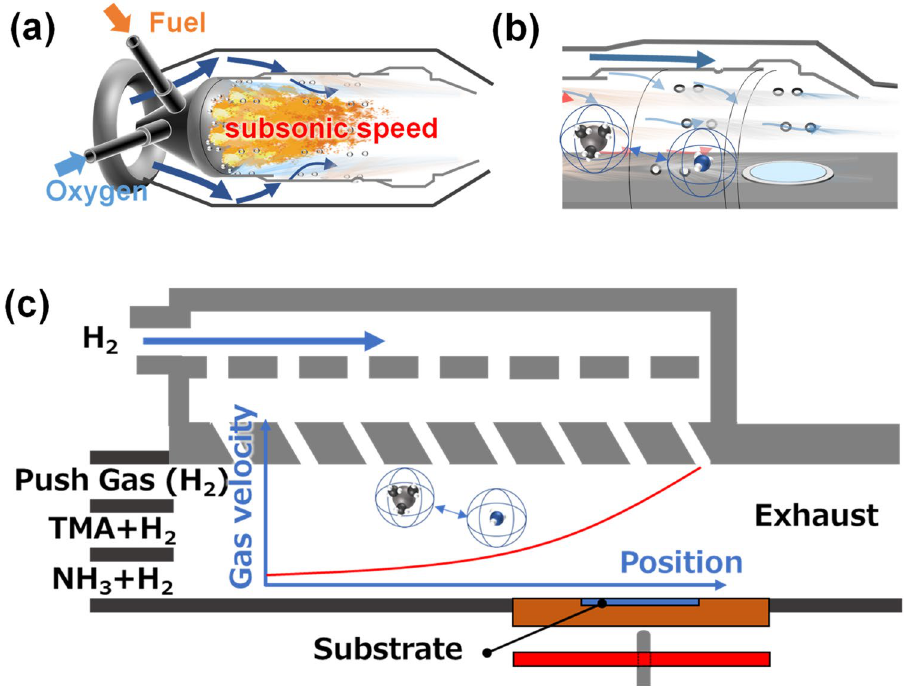
Figure 2. Schematic representation of the growth reactor involving gas flow from the jet engine. ( a ) The heating area in the combustion chamber of a jet engine. The temperature in this chamber exceeds 2000 °C ( b ) An image of raw materials gas flow in the combustion chamber. ( c ) The metal–organic vapor phase epitaxy reactor developed in this study, mimicking a combustion chamber in a jet